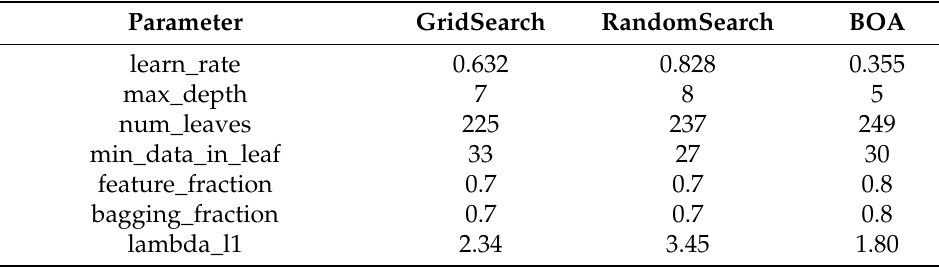
Table 4. Specific parameter values found by three tuning